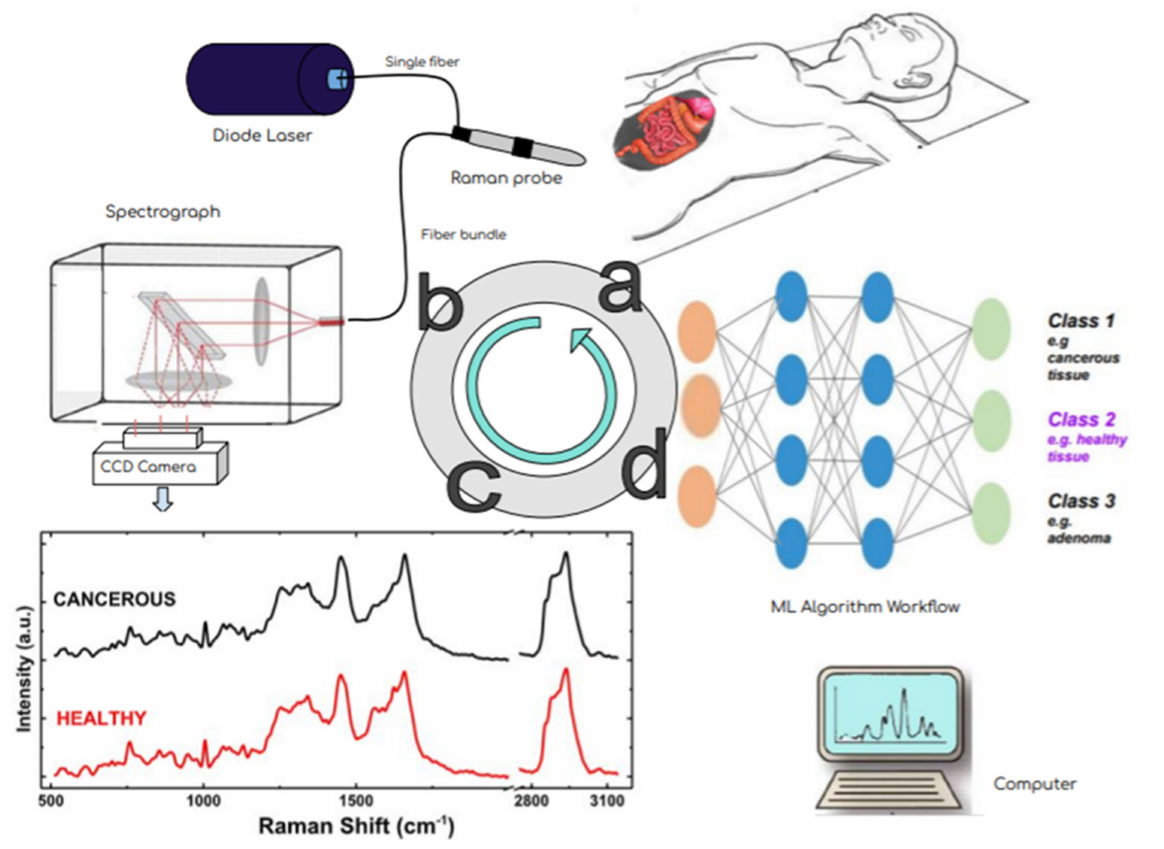
Figure 5. Effectiveness of oncologic surgery depends on precisely distinguishing healthy from malignant tissue during the operation. This flow diagram shows the steps of RS- based diagnosis from the patiant examination ( a ) via the multicomponent instrumentation (laser excitation–Raman probe-scattered light dispersion and detection) ( b ) in order to acquire the Raman spectra (schematic, not real data) in ( c ) and towards their analysis and classification via mashine learning techniques ( d ). A simple multi-layer perceptron neural network architecture is presented. In fact, the input layer is a data matrix with intensity values from different observations at various Raman frequencies. This combined methodology potentially has the ability to accurately differentiate benign from malignant tissue in real time and eventually improve the surgical